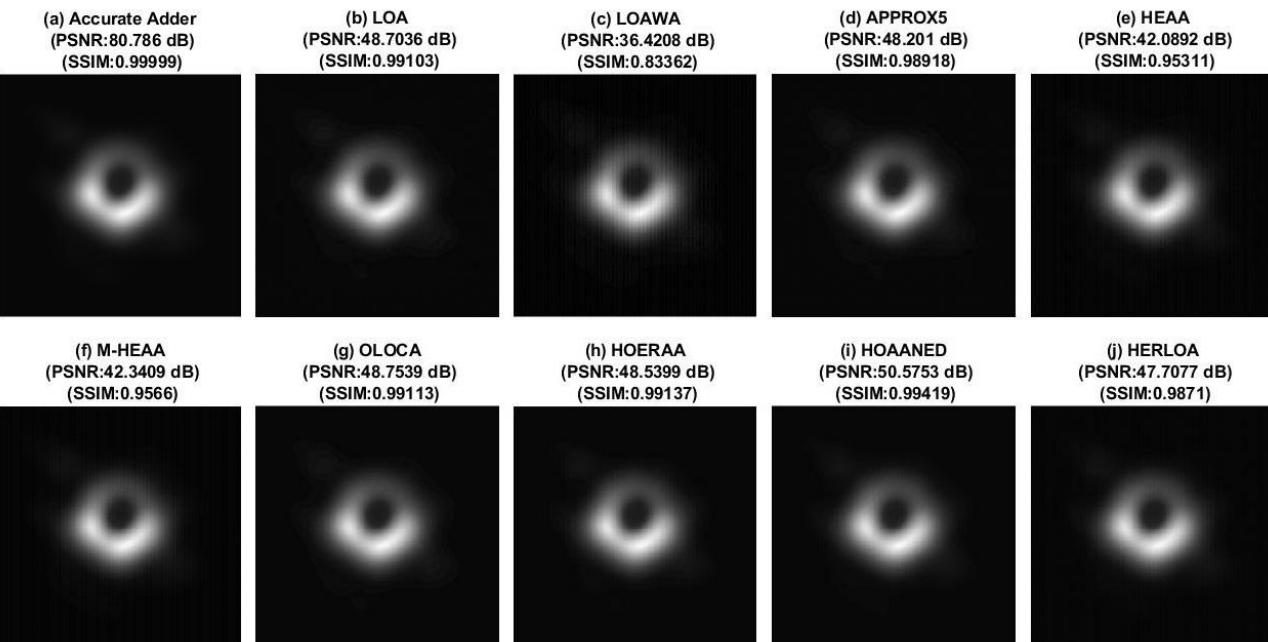
Figure 9. Black Hole image compressed using accurate adder and different approximate adders, with the approximate adders having a 10-bit inexact part.